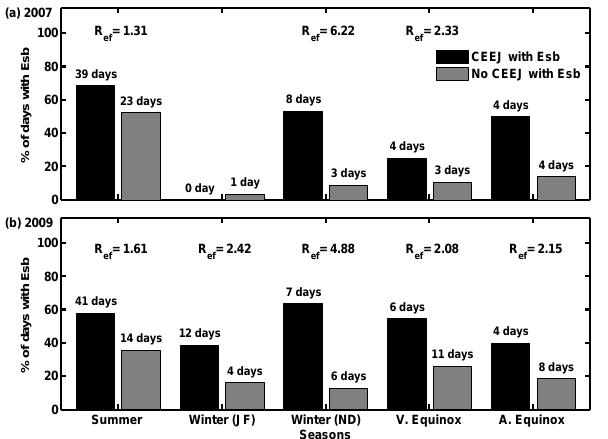
Figure 5. Percentage of number of E sb days for category I (with CEEJ) and category II (without CEEJ). The number of days dis- played above each bar represents the number of E sb days in the corresponding category. R ef is the ratio of percentage of days with E sb for category I to that for category II. R ef for winter (January– February), 2007 is not calculated due to fewer E sb days. R ef for autumnal equinox in 2007 is not calculated as there was large data loss during that period.